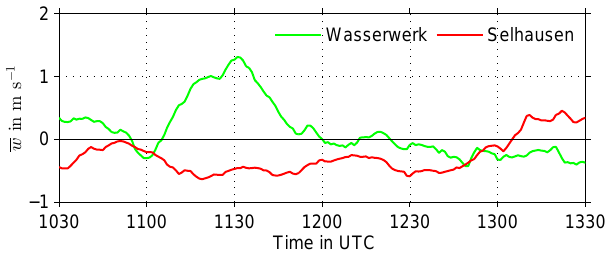
Figure 15. Mean vertical velocity (running average of 60min) at 700m ( ± 1 range gate) at Wasserwerk and Selhausen on 24